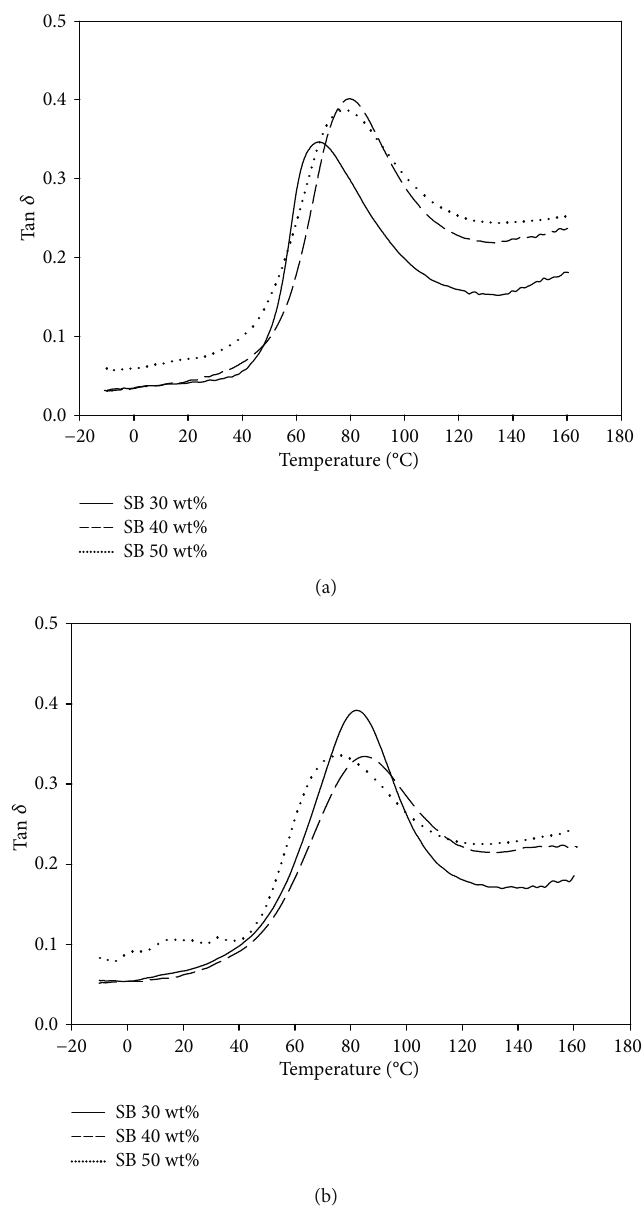
Figure 4: Tan δ of PU-EP grafted-IPNs added unmodi fi ed sugarcane bagasse. (a) PPG 700 PU-EP; (b) PPG 1000